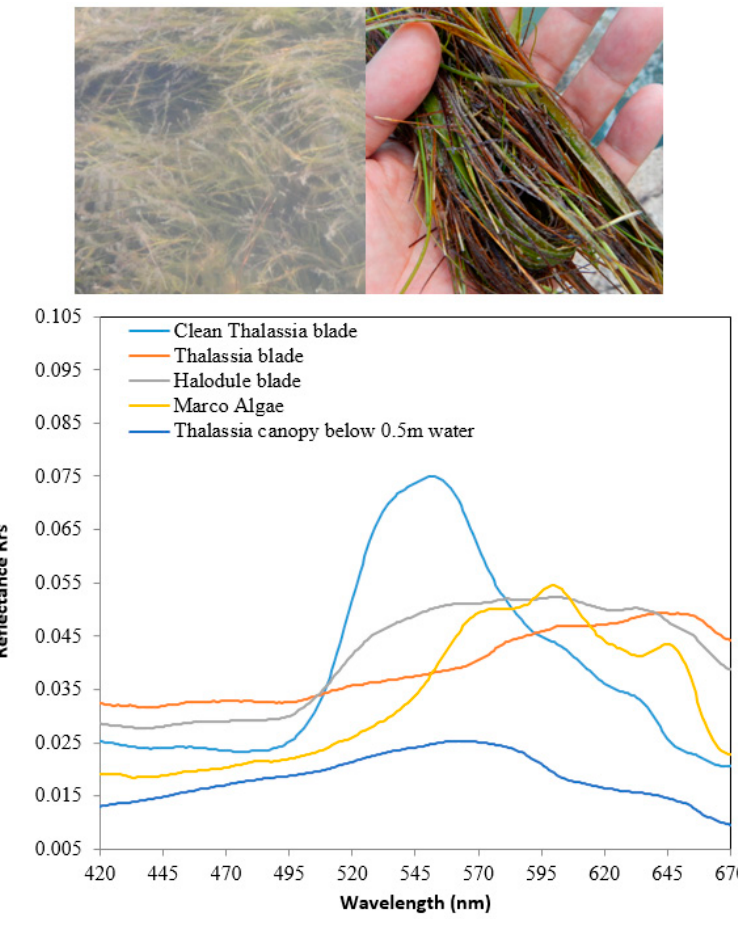
Figure 6. Reflectance of clean Thalassia blade, Thalassia blade with epiphyte, Halodule blade with epiphyte, draft algae, Thalassia canopy under 0.5 m water surface.